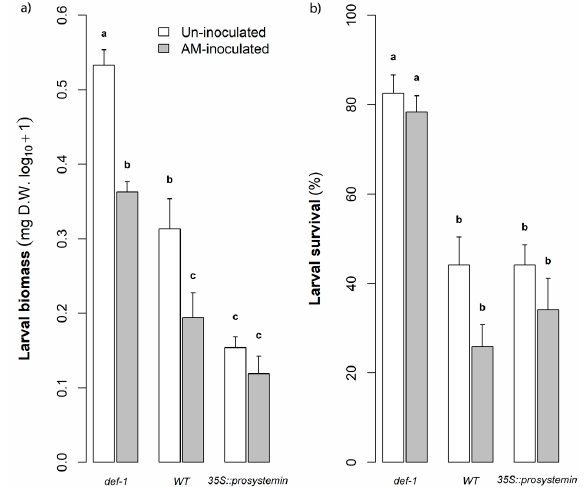
Figure 3. Effect of plant type and AM fungi treatment (mean + SE, n = 12) on ( a ) larval biomass (mg D.W., log 10 + 1) and ( b ) larval survival (%). Grey solids and dotted black lines represent AM-inoculated and un-inoculated plant respectively. Plant type: JA expression deficient plants (def-1), wild-type plants (WT) and prosystemin constitutive expression plants (35S::prosystemin). Larvae were placed on plants after seven weeks of growth and larval biomass and mortality were measured after one week of feeding on plants. Letters above the bars indicate significant difference according to Tukey’s mean separation test ( p <